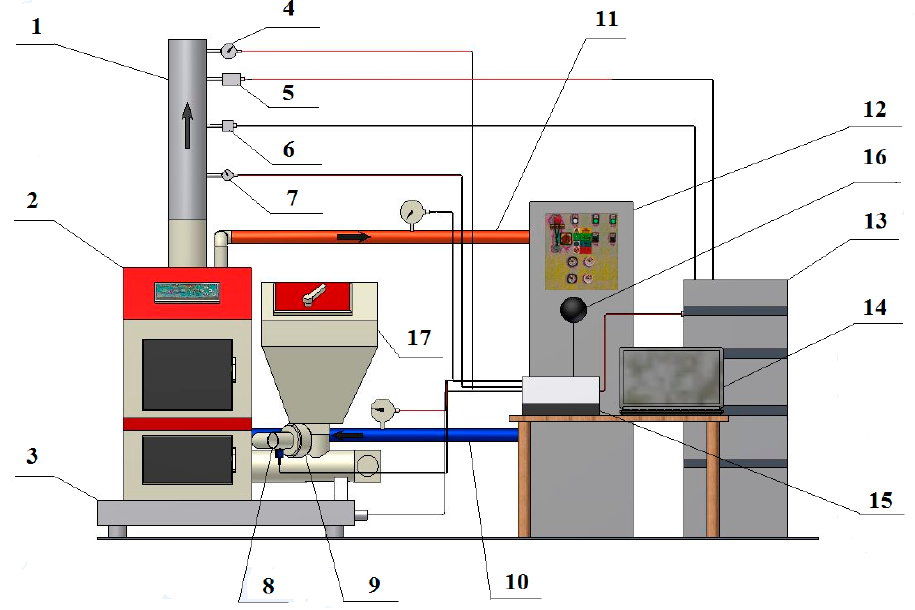
Figure 5. Furnace experiment setup. 1—chimney; 2—automatic pellet boiler; 2—weight; 3—chimney draft sensor; 4—PM probe (solid pollutants); 6—emissions probe; 7—thermometer for measuring flue gas; 8—anemometer; 9—fan; 10—supply pipe; 11—drainage pipe; 12—control center; 13—flue gas analyzer; 14—computer; 15—measuring station; 16—Vernon thermometer; 17—fuel tank.